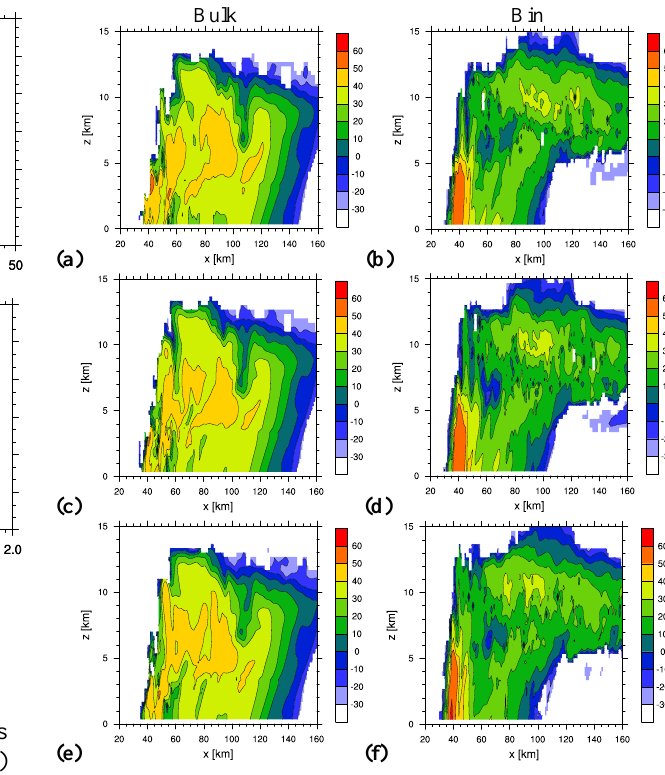
Fig. 14. As in Fig. 8 except for the lowRH